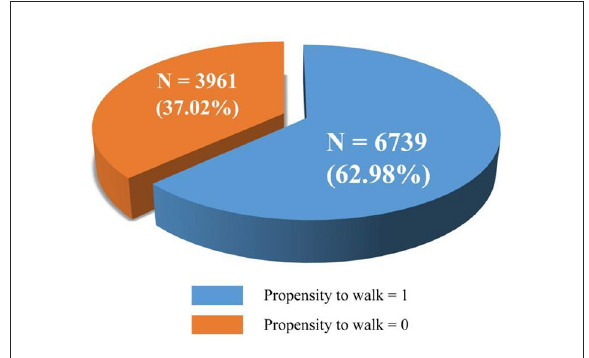
FIGURE1 Propensity to walking details of the sampled older adults.